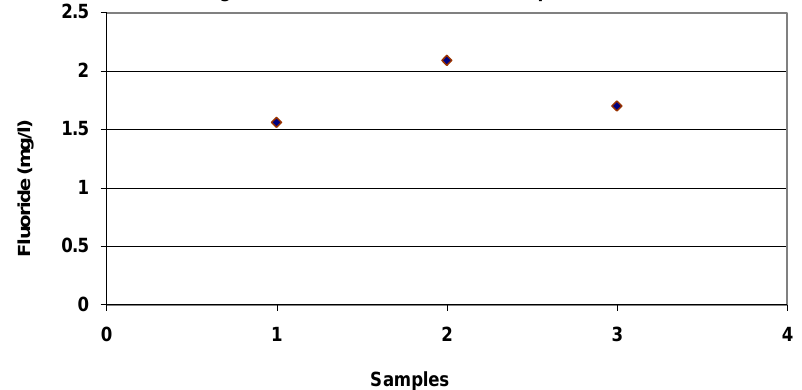
Figure-6: Range of fluoride contaminated samples (>1.5mg/l) in NWFP Figure 6. Range of fluoride-contaminated samples ( > 1.5mgL − 1 ) in NWFP.